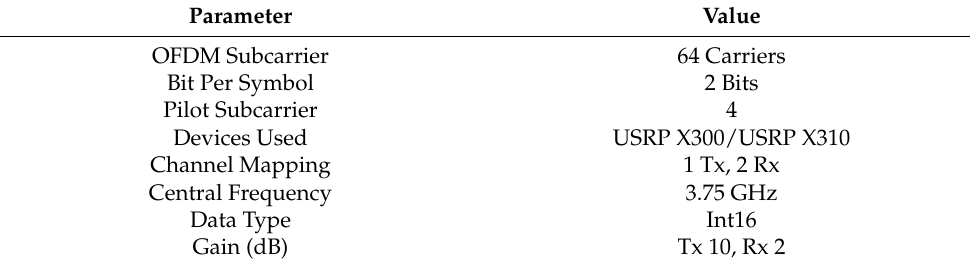
Figure 3. A wireless single-input, single-output communication technology supported by the IRS. ( a ) The IRS and Rx build a feedback loop to gradually increase the signal intensity from the Tx to the Rx antenna in order to overcome the obstacle. ( b ) A reconfigurable intelligent reflecting surface. The inset illustrates a column with choke inductors at the top. The 12 unit cells that make up the highlighted column are connected at the bottom and top by patches [39]. Table 2. Parameters for configuring USRP hardware and